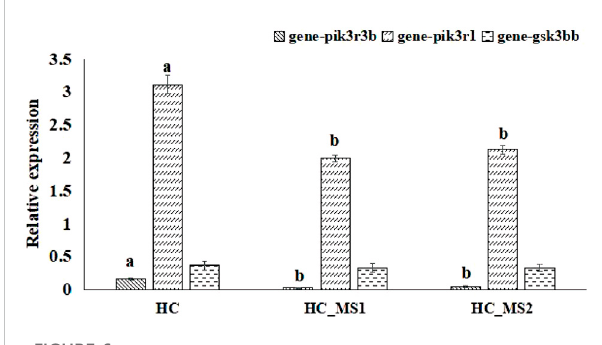
FIGURE 6 Quantitativeexpression veri fi cationoftheselected genesrelated to insulin signaling pathway and insulin resistance of common carp based on RNA-seq (n =